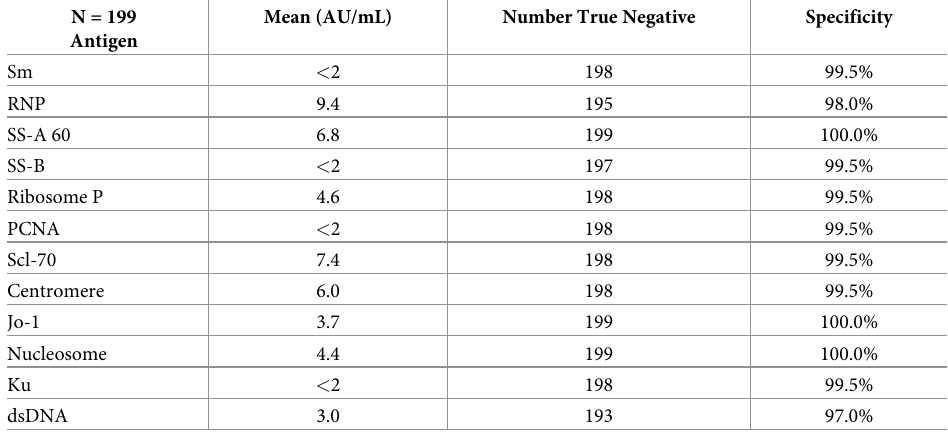
Table 3. Clinical specificity of ANA 12